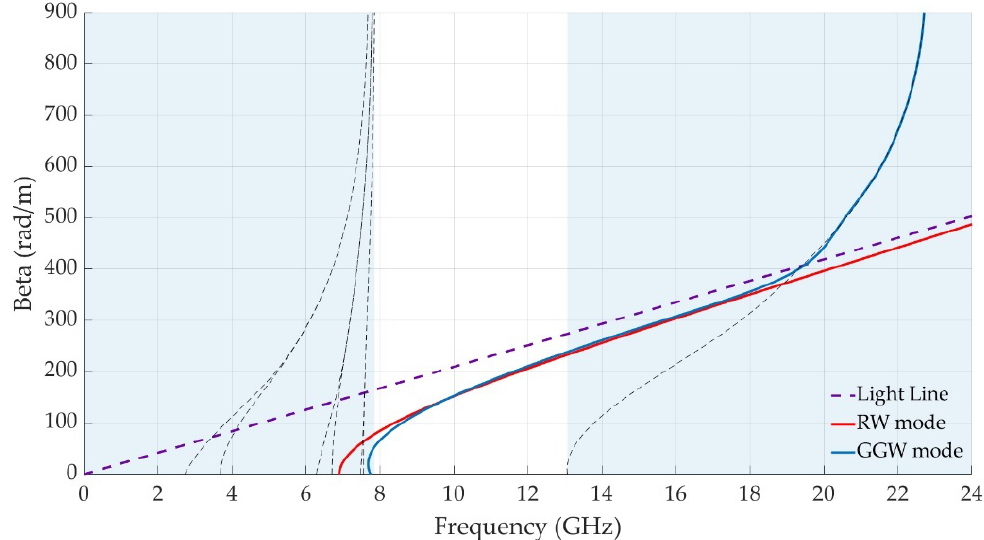
Figure 2. Groove gap waveguide dispersion diagrams.